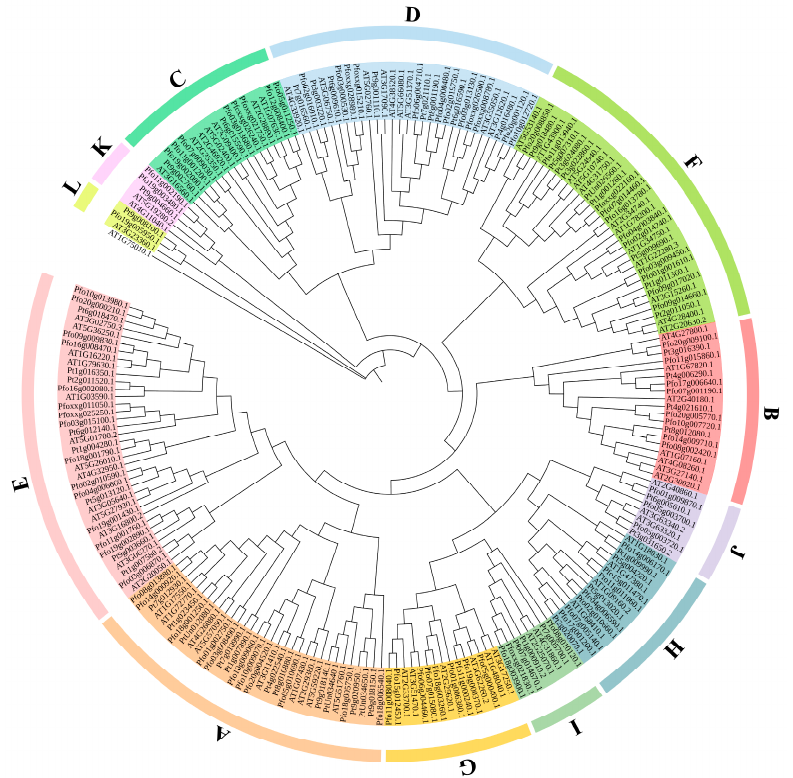
Figure 3. Phylogenetic tree of the PP2C gene family in A. thaliana ( At ), P. trifoliata ( Pt ), and P. fortunei ( Pf